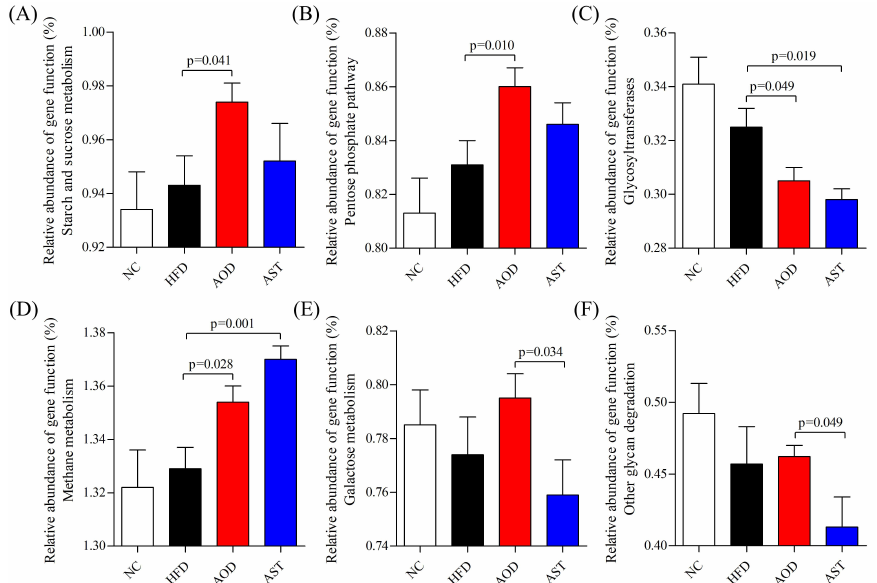
Figure 7. Select biological pathways and functional categories of gut microbiota displaying di ff erences in relative abundance of gene function (%). ( A ) Starch and sucrose metabolism. ( B ) Pentose phosphate pathway. ( C ) Glycosyltransferases. ( D ) Methane metabolism. ( E ) Galactose metabolism. ( F )